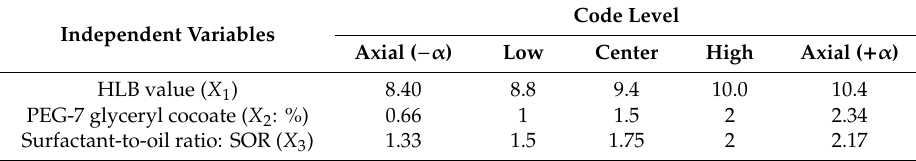
Table 1. Levels of independent variables created according to the central composite